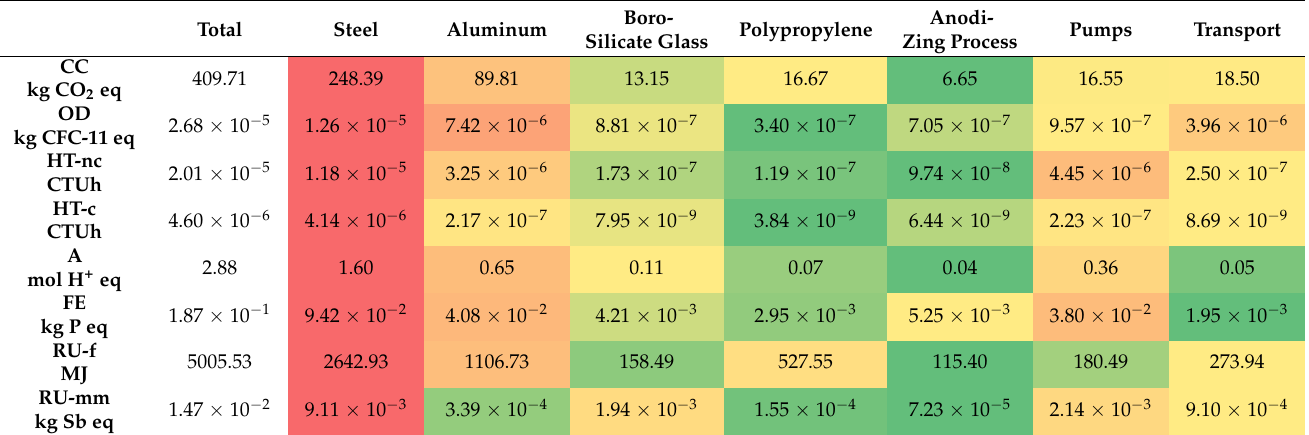
Red: high impact. Yellow-Orange: medium impact. From light green to dark green: from low to very low impact.